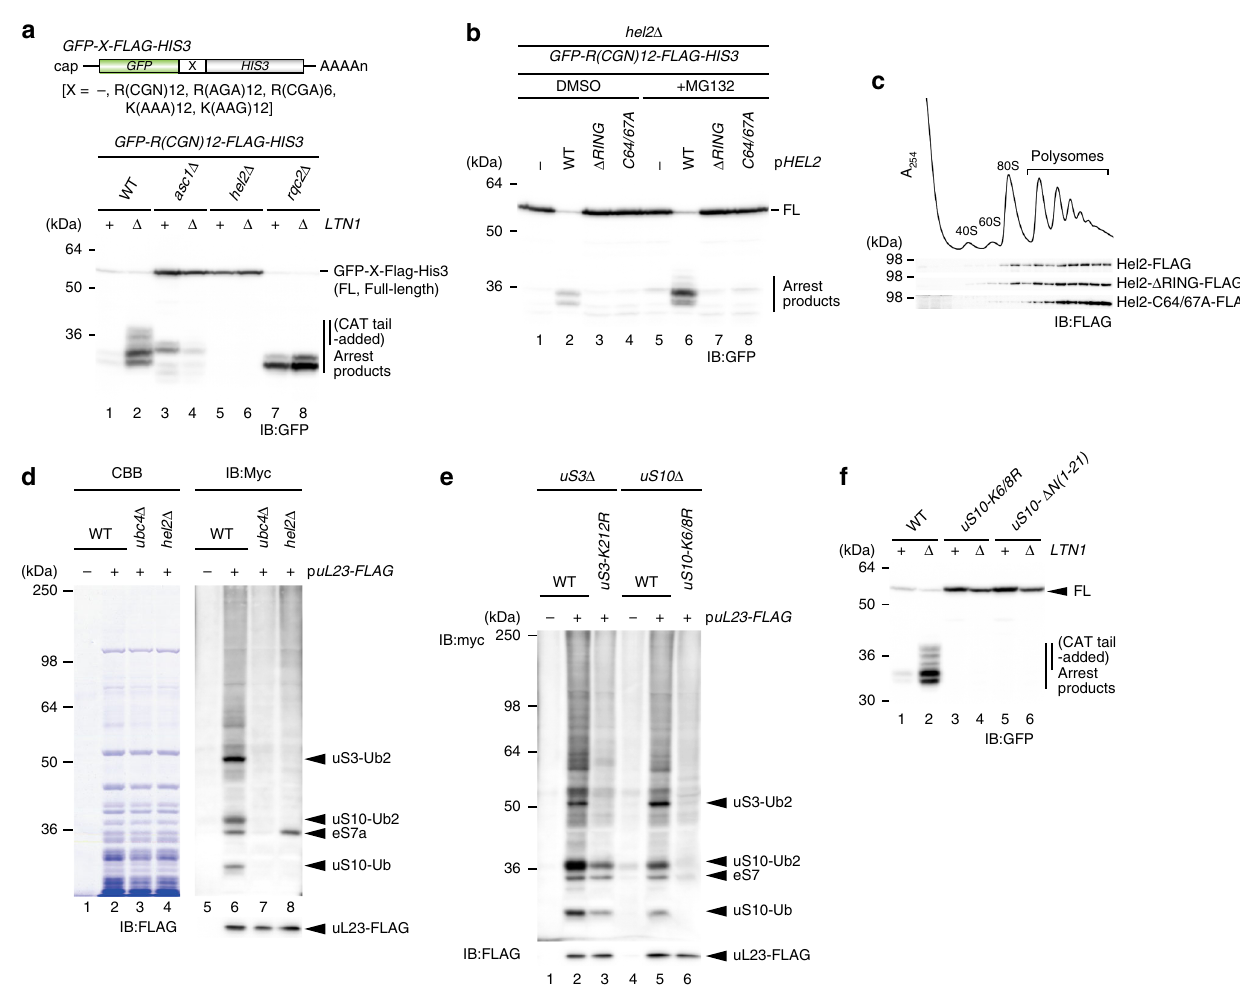
Fig. 1 Hel2-dependent ubiquitination was required for a triggering step of RQC pathway. a An E3 ubiquitin ligase Hel2 was required for not only translation arrest, but also the production of arrest products. b The ubiquitination activity of Rqt1 was crucial for induction of RQC. c The distribution of Rqt1 proteins in polysome pro fi les. d The ubiquitinated proteins in ribosome depended on Hel2/Rqt1 and Ubc4. Arrowed proteins were identi fi ed by mass spectrometry. e K212 residue of uS3 and K6 and K8 residues of uS10 were ubiquitination sites of them. f Hel2-dependent ubiquitination of uS10-K6/8 was crucial for induction of RQC